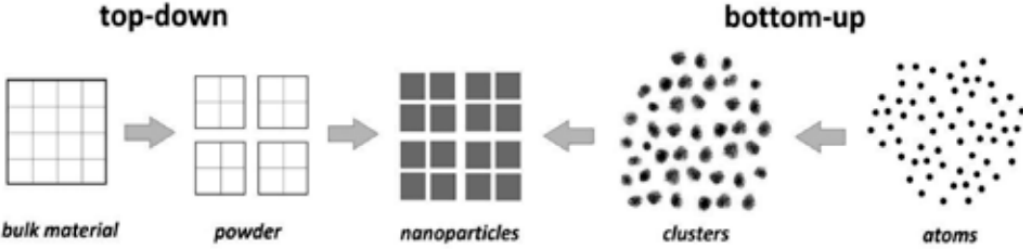
Figure 6. Nanomaterial synthesis route of nanomaterials following top-down, or bottom-up. Adapted from [107], with permission from CHEMIK, 2014.